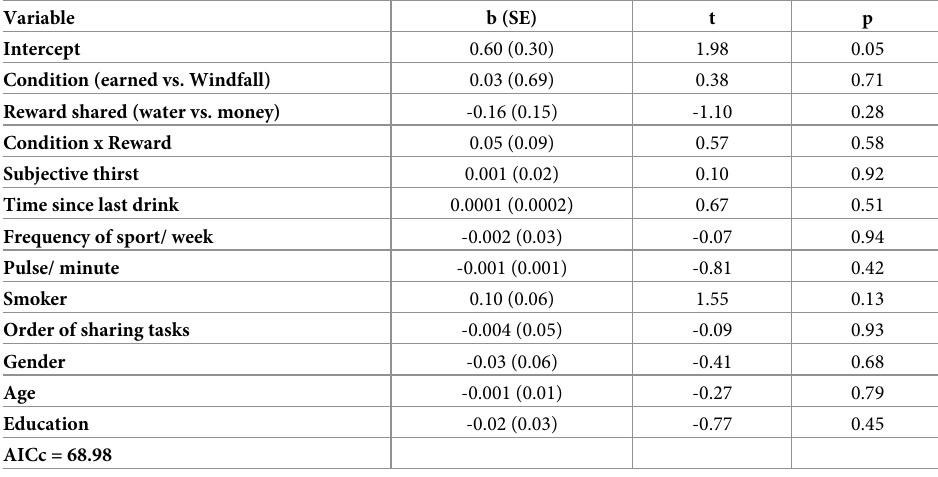
Table 2. Multilevel regression, predicting expected Dictator Game offers in